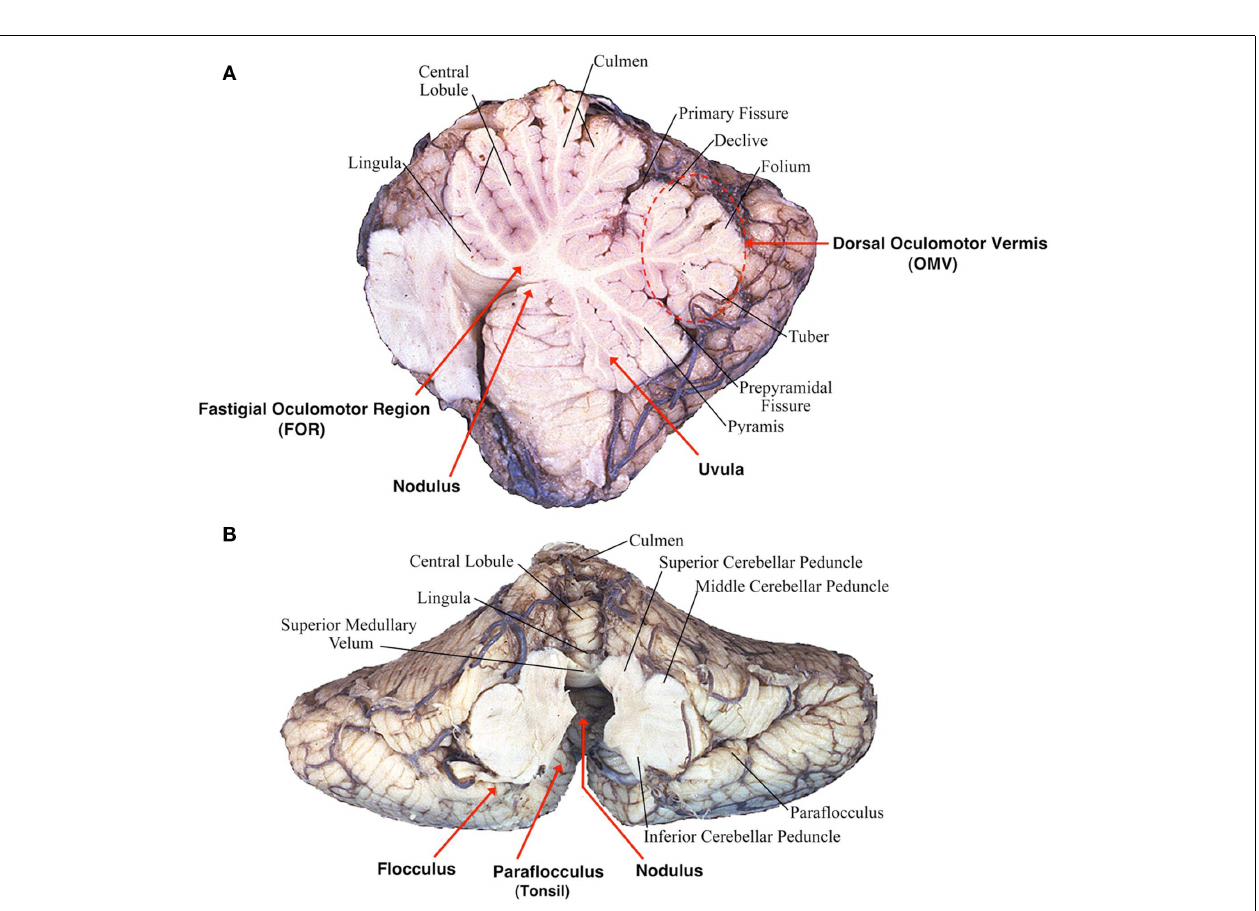
FIGURE 1 | Cerebellar structures important for eye movement control: (A) sagittal view (B) inferior view (modified after Leigh and Zee, 2006).